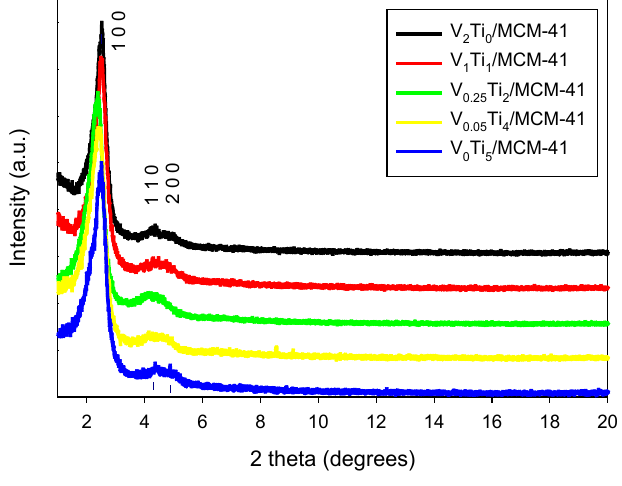
Figure 1. XRD patterns of V-Ti/MCM-41 catalysts.